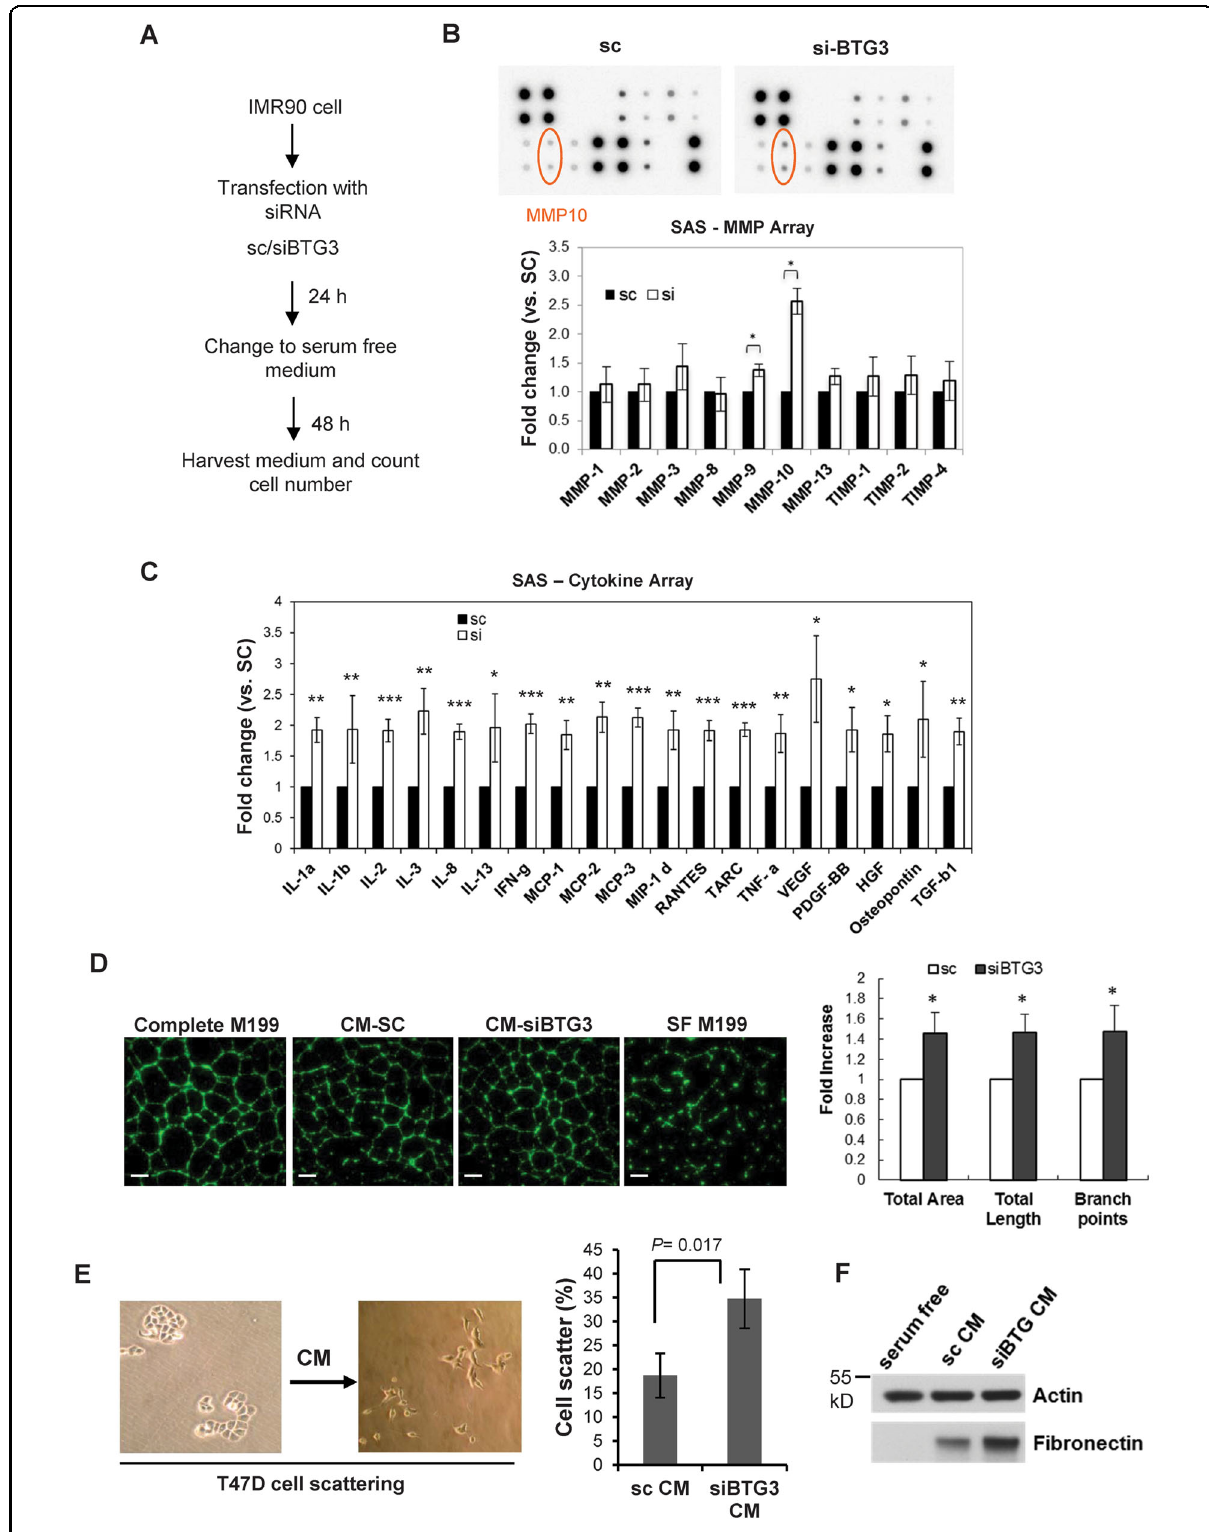
Fig. 1 (See legend on next